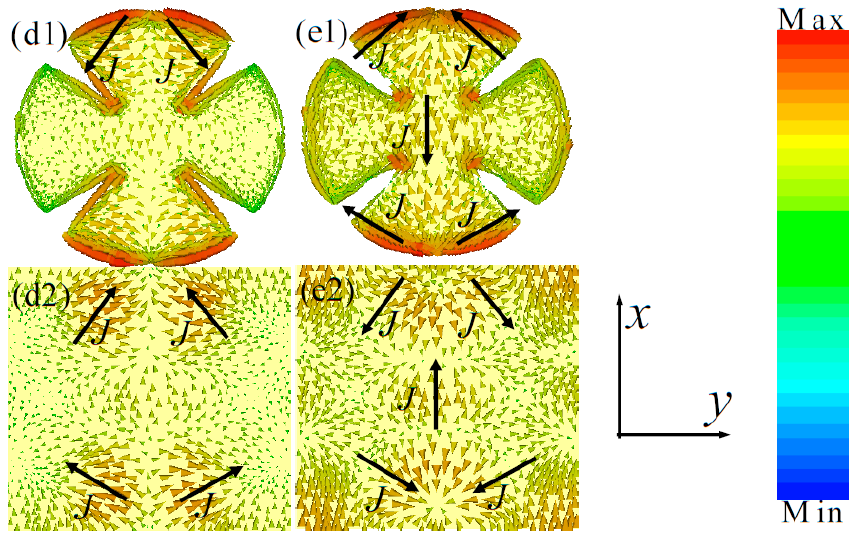
Figure 8. The surface current distributions of the ( a1 – e1 ) front and ( a2 – e2 ) back metallic layer of the unit-cell structure at different resonant frequencies: ( a1 , a2 ) f 1 = 3.42 GHz; ( b1 , b2 ) f 2 = 7.88 GHz; ( c1 , c2 ) f 3 = 11.48 GHz; ( d1 , d2 ) f 4 = 13.9 GHz; and ( e1 , e2 ) f 5 = 15.22 GHz. The solid arrow indicates the flow directions of surface currents at the two metallic layers.